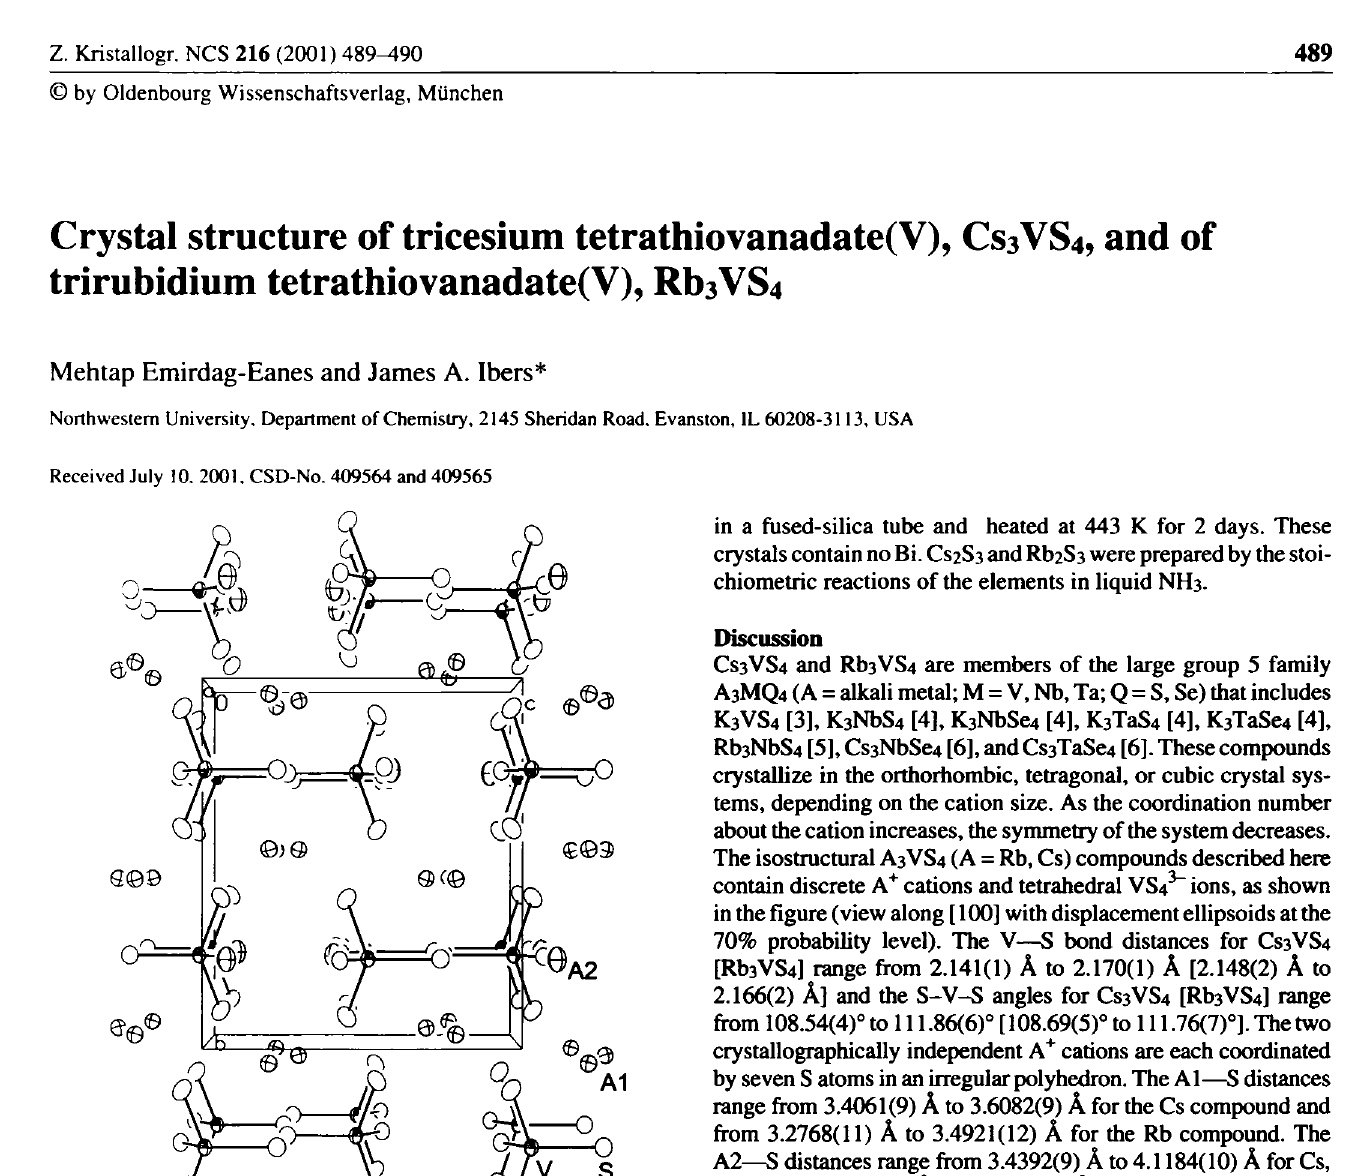
Table 1. Data collection and